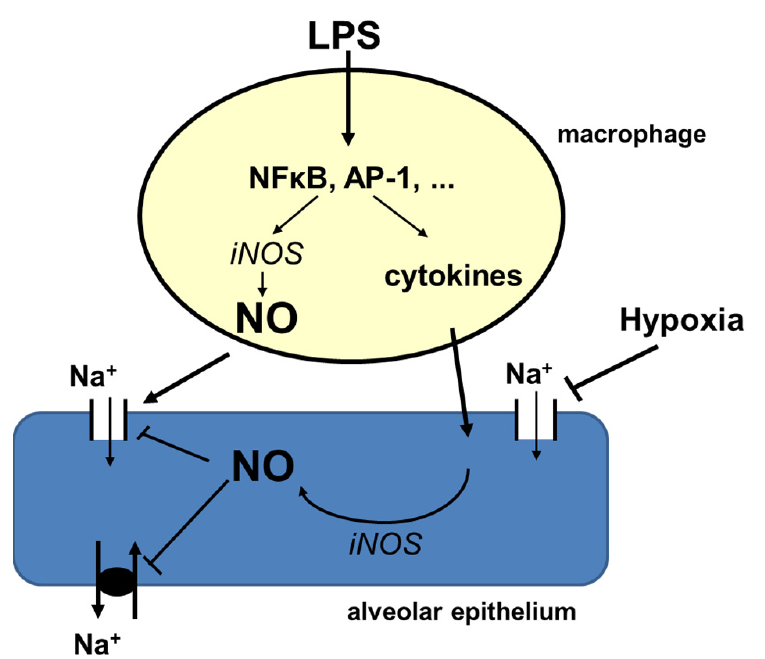
Figure 6. Alveolar macrophages release cytokines, chemokines, nitrite and related products upon stimulation with LPS which impair alveolar epithelial Na-transport by NO-dependent mechanisms that can be prevented by blocking iNOS activity in macrophages. iNOS is also activated in alveolar epithelial cells in response to cytokine and nitrite related products released from activated macrophages. Hypoxia by its direct effects on the alveolar epithelium additively inhibits alveolar epithelial barrier tightness and ion transport in lung inflammation.